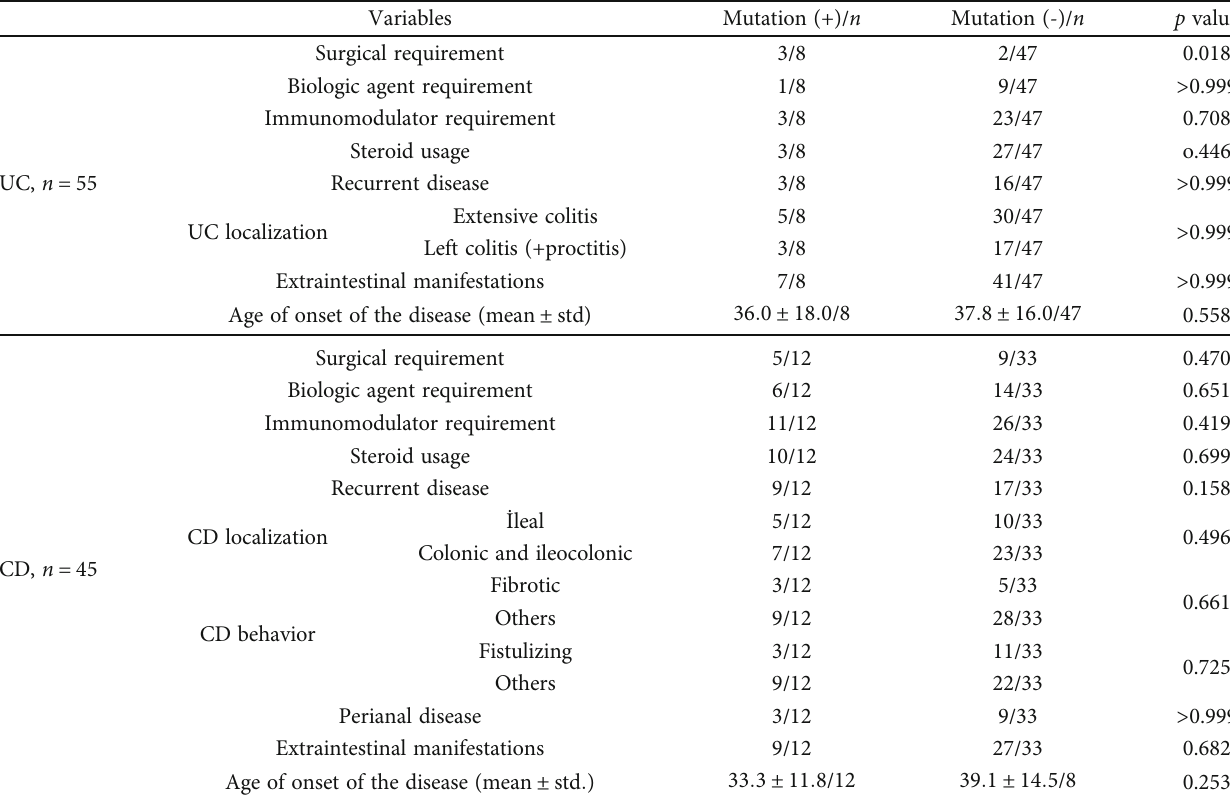
Table 4: E ff ect of MEFV mutations on clinical